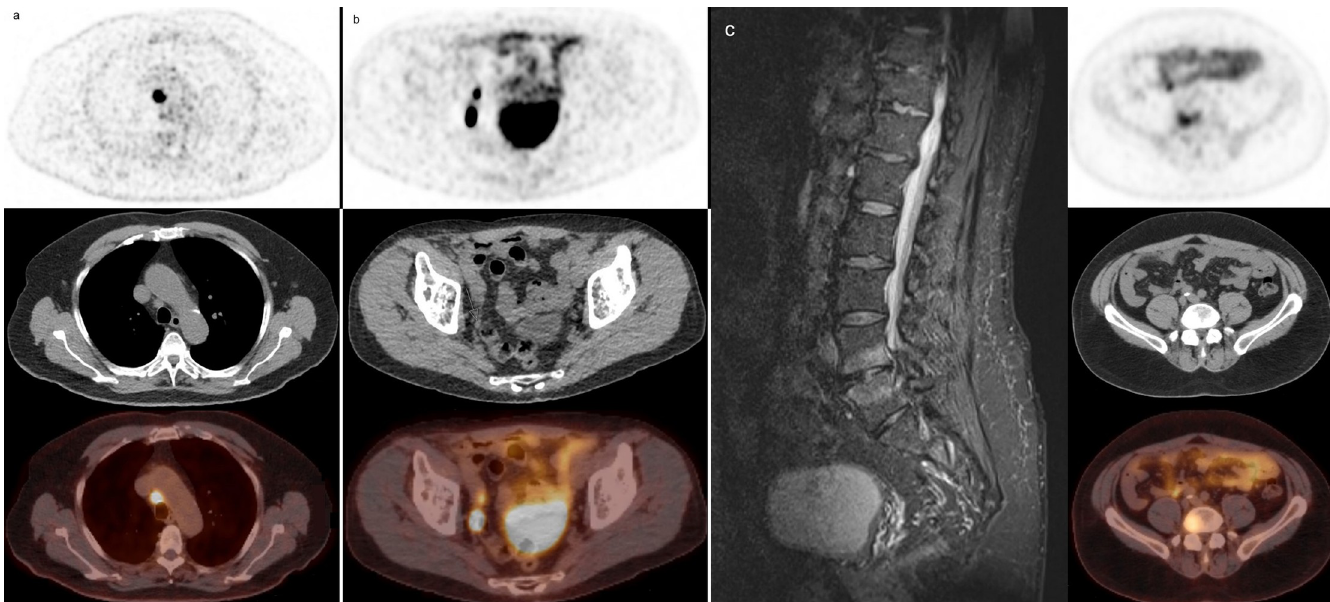
significantly lower (40–50%) [47]. This apparent difference means that thorough analysis of PET-detected lesions in patients with BCR is warranted, as a higher sensitivity might increase the number of false positives. Identifying a lesions as false positive could have a significant impact on management decisions. Therefore, we retrospectively verified the nature of 18 F-DCFPyL PET-detected lesions in 262 patients with BCR for which any form of validation was present.